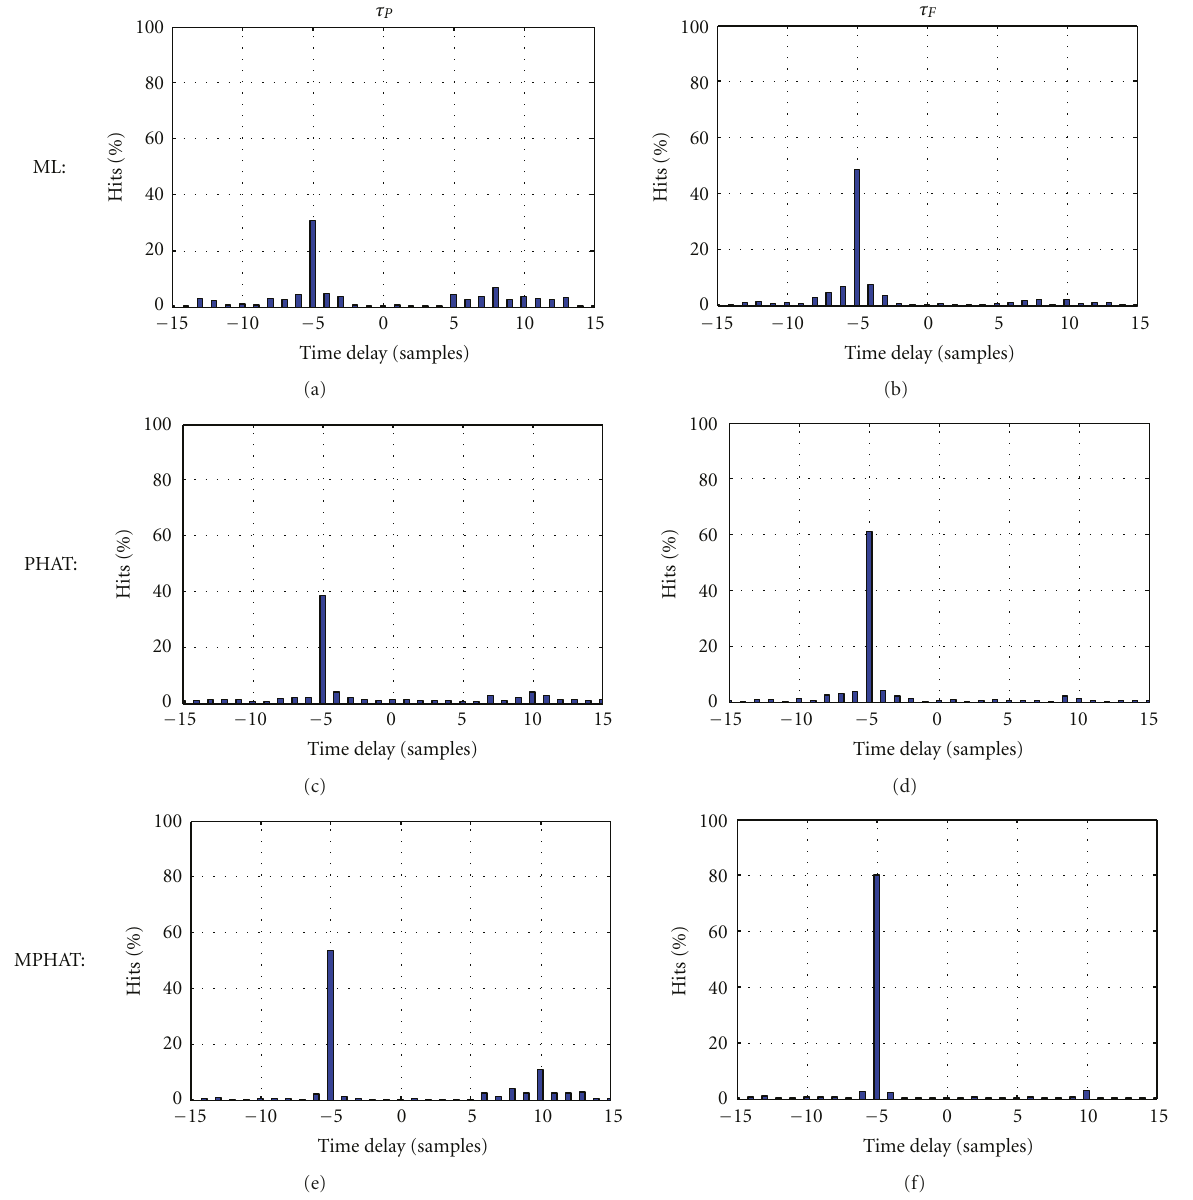
Figure 6: Comparison between (a, c, e) primary TDOA ( τ P ) and (b, d, f) final TDOA ( τ F ) values estimated using the hybrid algorithm (exact value of TDOA is ( − 5)